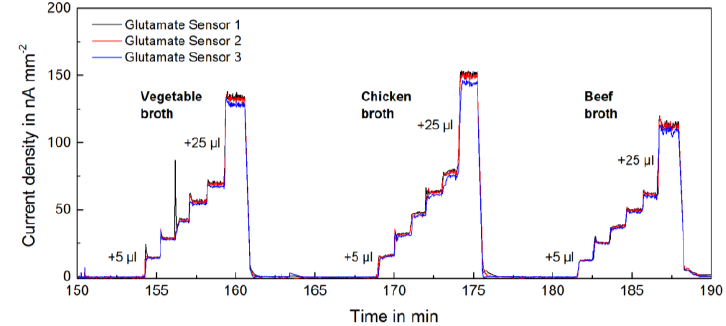
Figure 2. Transient raw signal (blank subtracted) from 3 glutamate sensors upon addition of different types of food samples (instant broth).